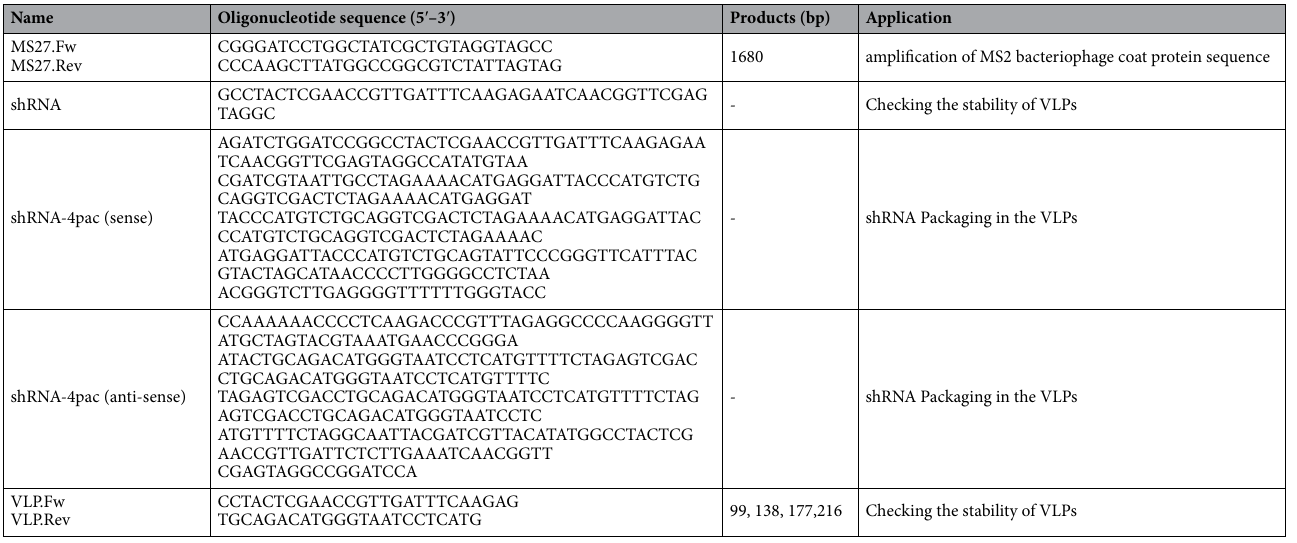
Table 1. Primers and oligonucleotides used in this